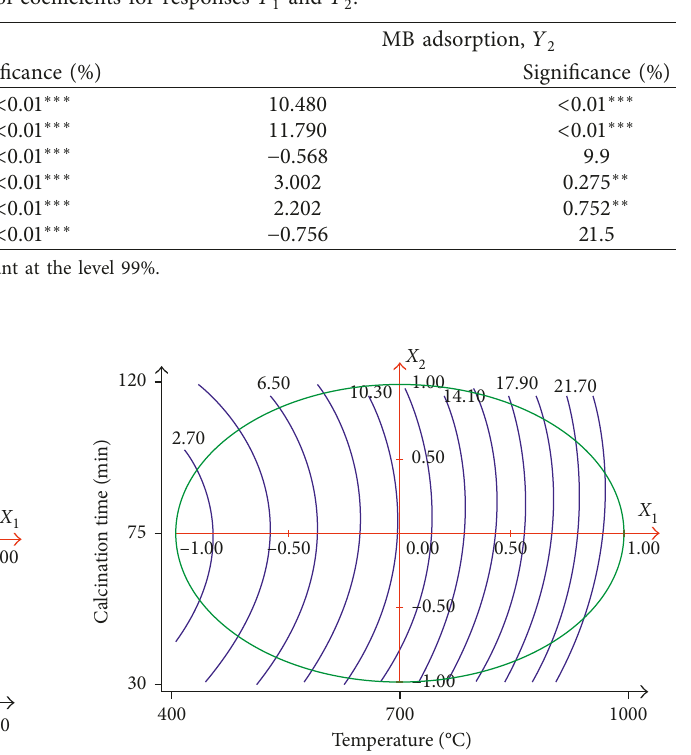
Table 4: Estimated values of coefficients for responses Y